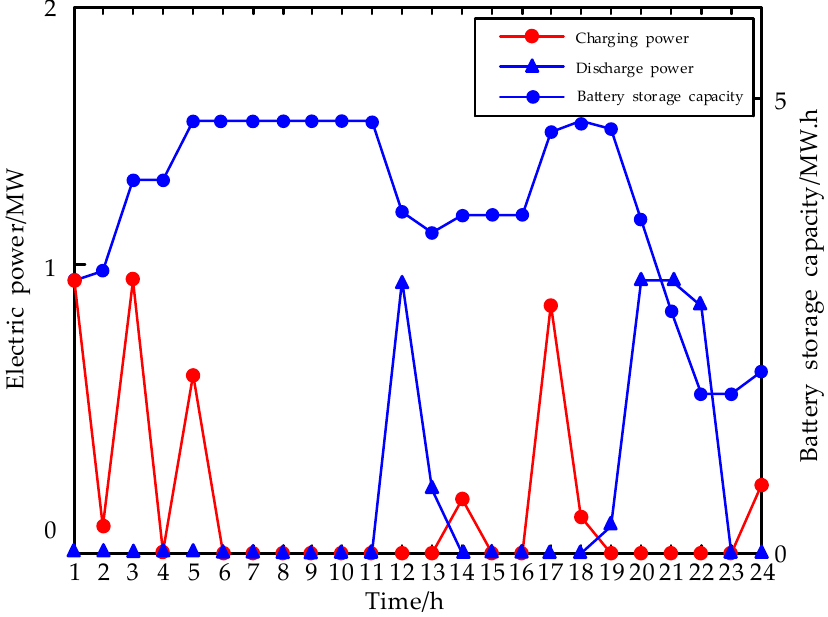
Figure 7. Storage battery capacity and charge and discharge power.